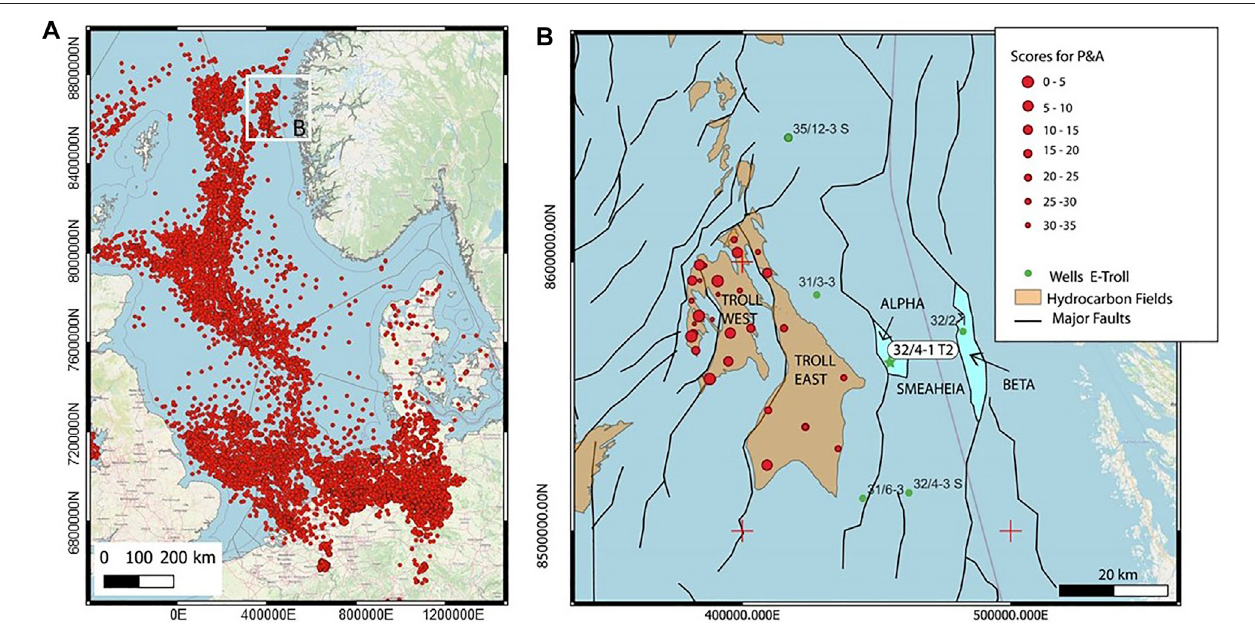
FIGURE1|(A) MapoftheNorthSeawithwelllocations.Whiteboxindicatestheworkingarea. (B) Mapoftheworkingarea(offshoreSWNorway)withwellintegrity screeningresultsforP&A(reddots)fromtheTrolloilandgas fi eld(EmmelandDupuy,2021).ThemapsareinaWGS1984pseudomercadoprojectionandareproduced using QGIS (QGIS.org, 2022). Major faults are shown, and the location of well 32/4-1 T2 within the alpha structure is highlighted and marked with a green star.